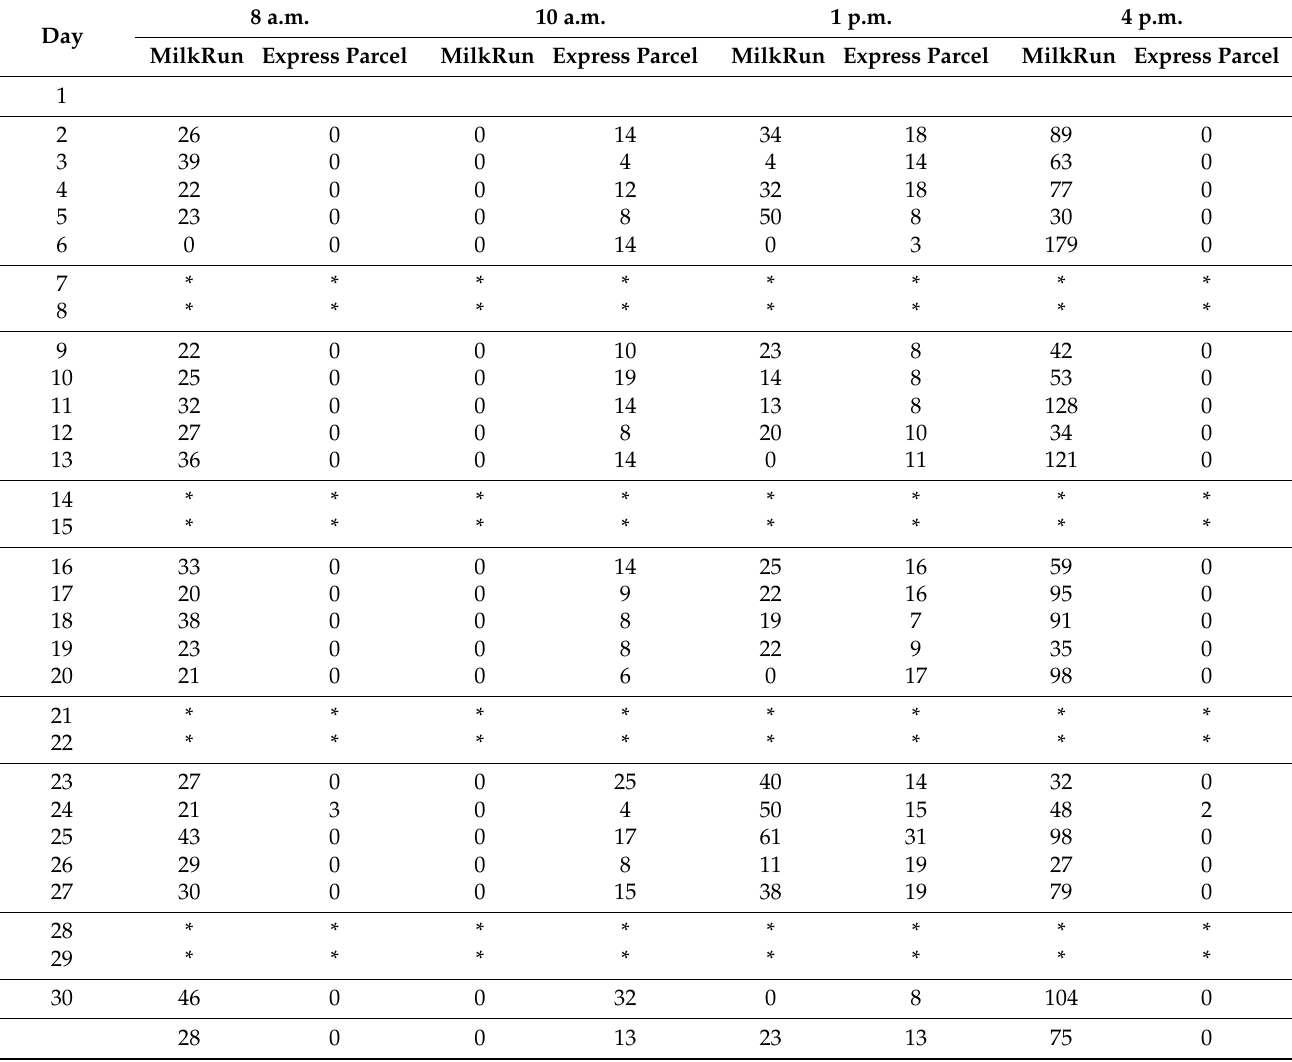
Table 3. Daily distribution of Single Code pallets received by type and time during November 2020.